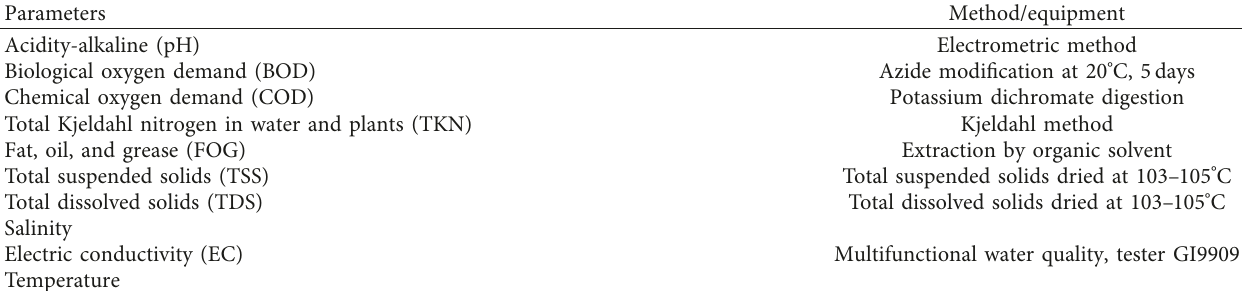
Table 2: The parameters and corresponded method/equipment used in the analysis.